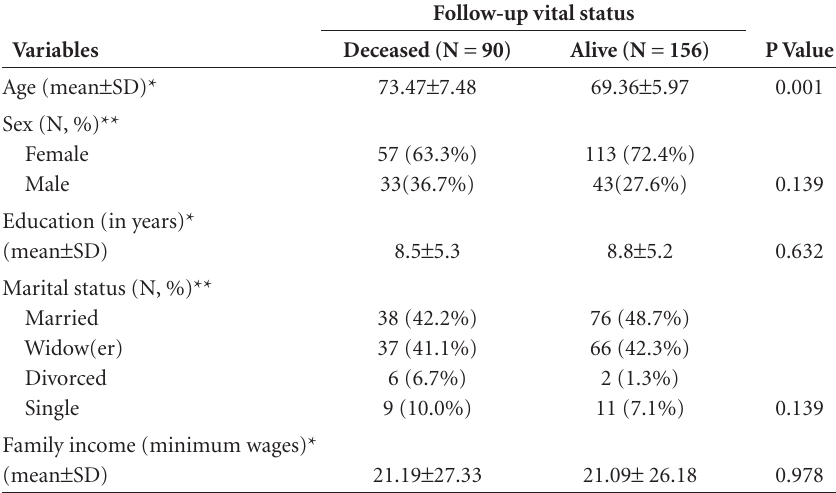
Table 2. Socio-demographic baseline data of sample according to outcome (vital status) during